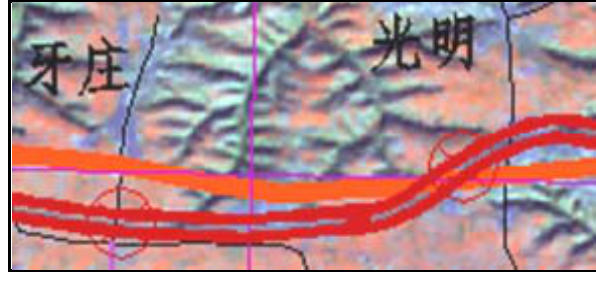
Figure 5. Roadway updating with GPS